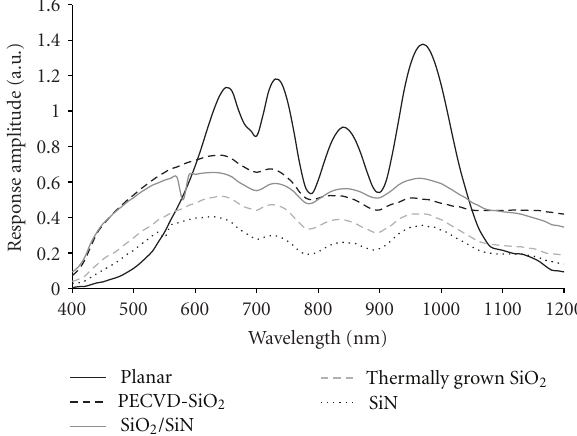
Figure 5: Reflectance spectra of SiN, thermally grown SiO 2 , PECVD-SiO 2 , and SiO 2 /SiN stack compared to planar wafer.